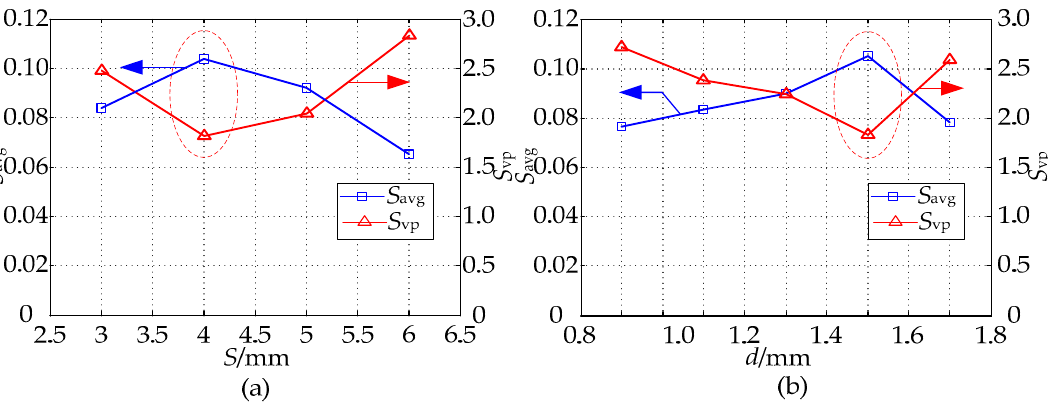
Figure 5. The effect of the MCP geometry on S avg and S vp : ( a ) effect of the parameter S ( D = 20 mm, h = 3 mm, d = 1.5 mm); ( b ) effect of the parameter d ( D = 20 mm, h = 3 mm, S = 4 mm).